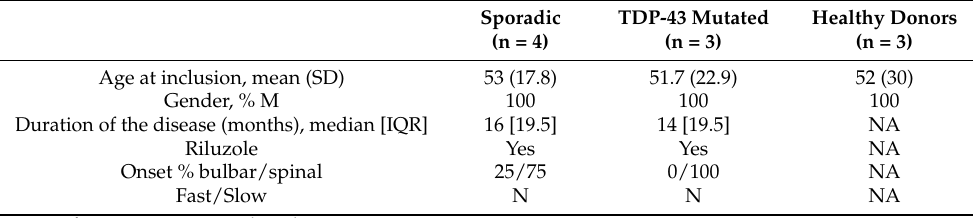
Table 1. Summary of clinicopathological characteristics of patient